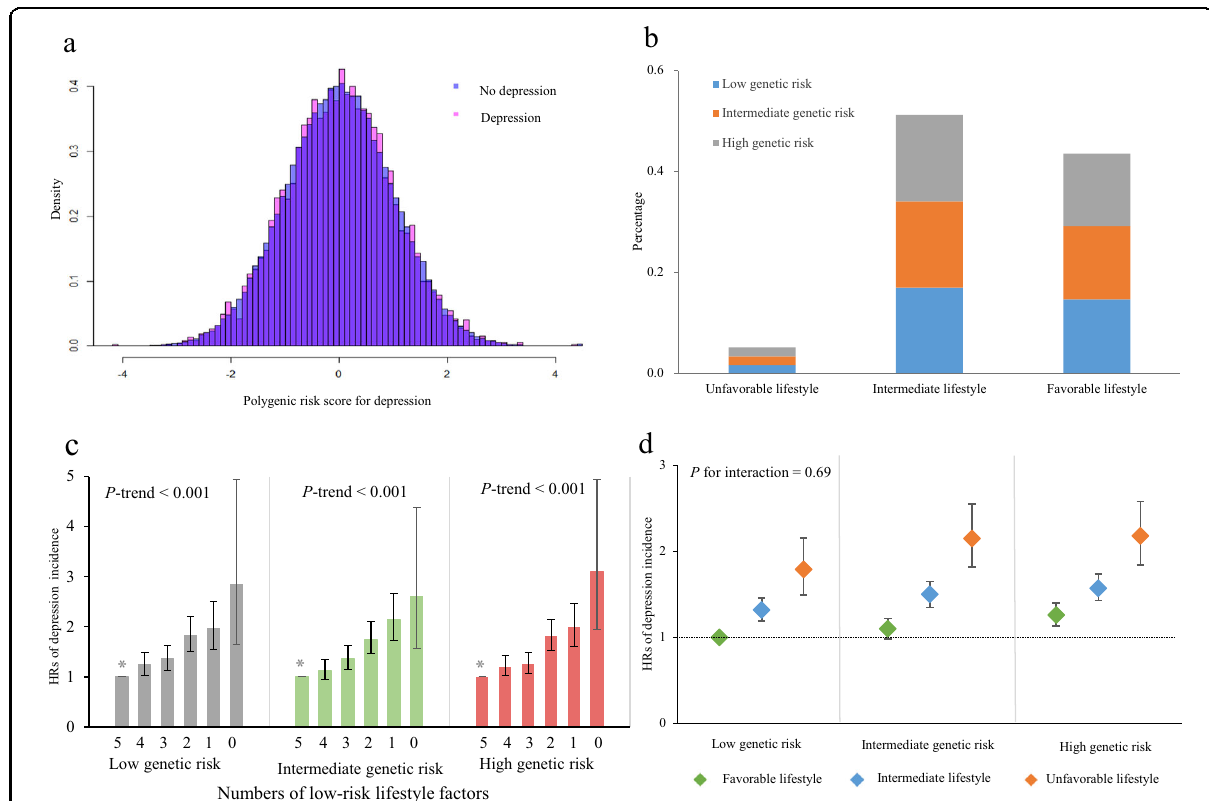
Fig. 1 Risk of incident depression according to combined genetic risk and lifestyle factors pro fi le. a Distribution of PRS by incident depression; b percentage of genetic risk according to lifestyle factors categories; c numbers of healthy lifestyle factors and depression according to genetic risk categories; d the risk of combined genetic risk and lifestyle factors pro fi le for incident depression.